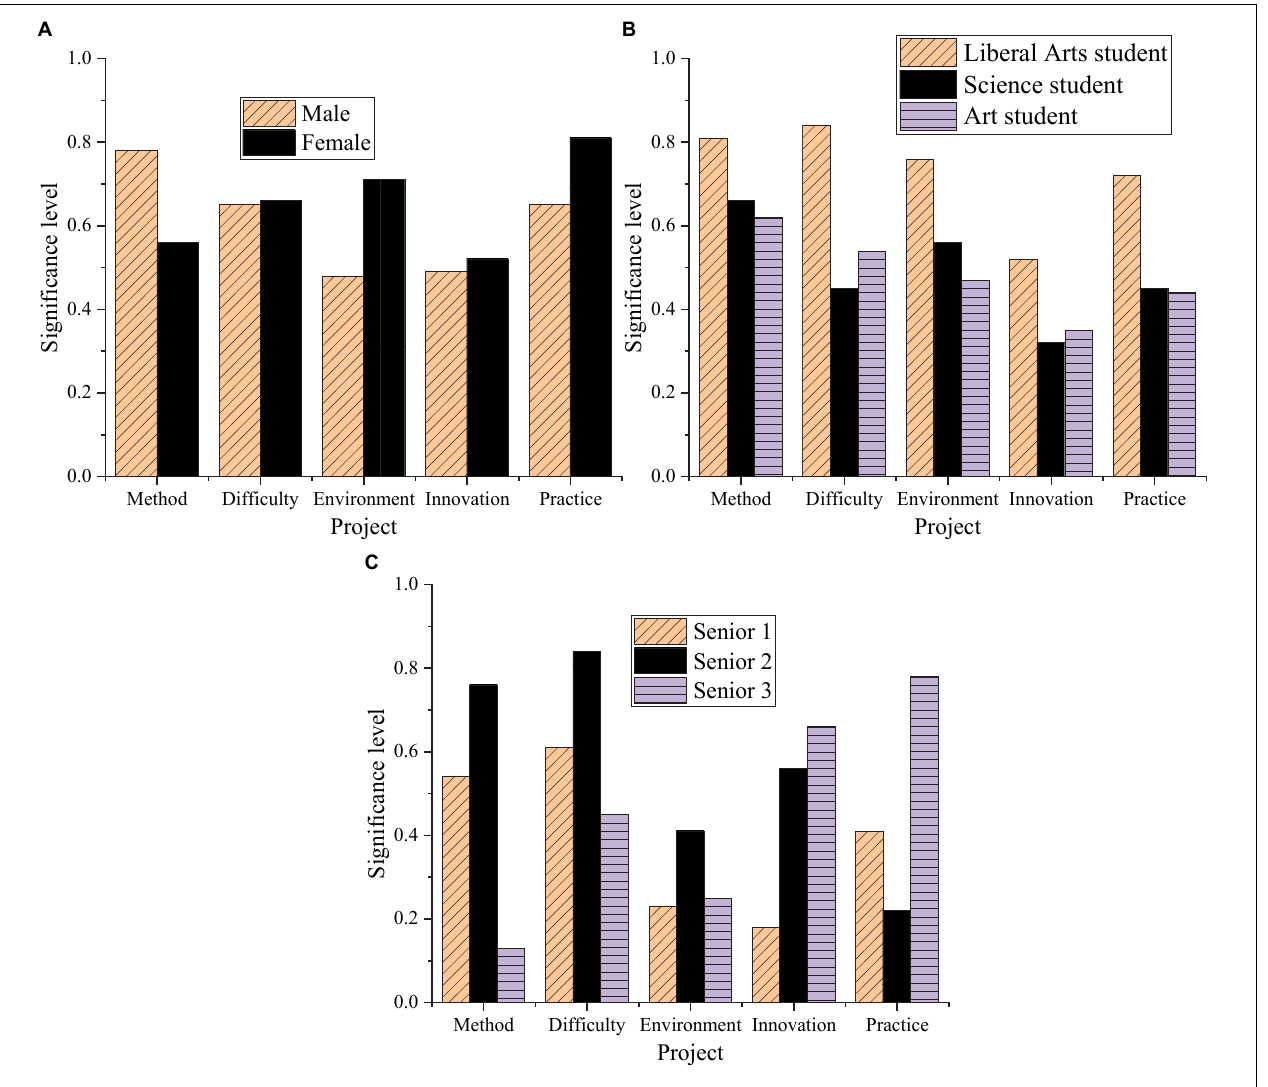
FIGURE 5 | Analysis of the effect of Science, Technology, Engineering, Art, and Mathematics (STEAM) teaching (Panel A: gender classification, Panel B: learning direction classification, Panel C: grade classification).